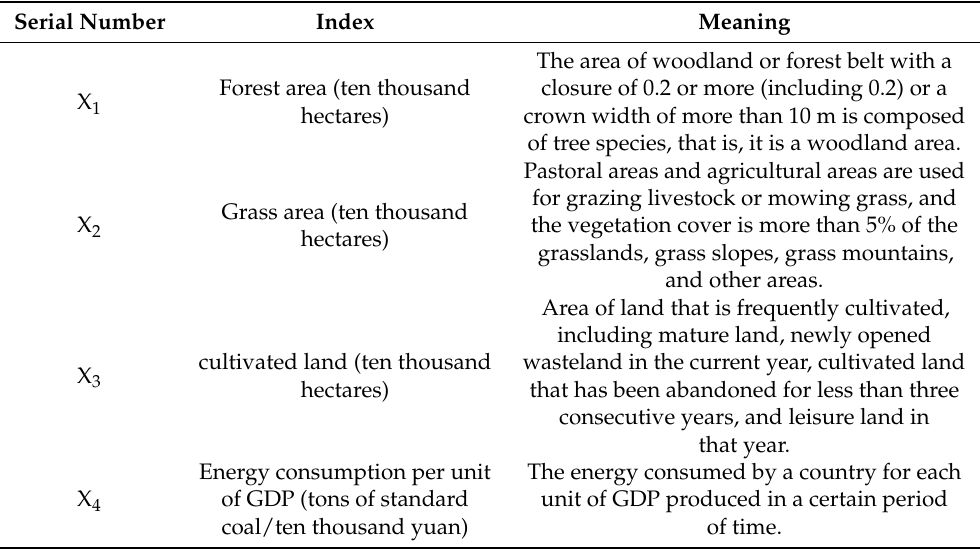
Table 3. Indicators and index interpretation of the carbon neutral capacity of ecological prod- uct